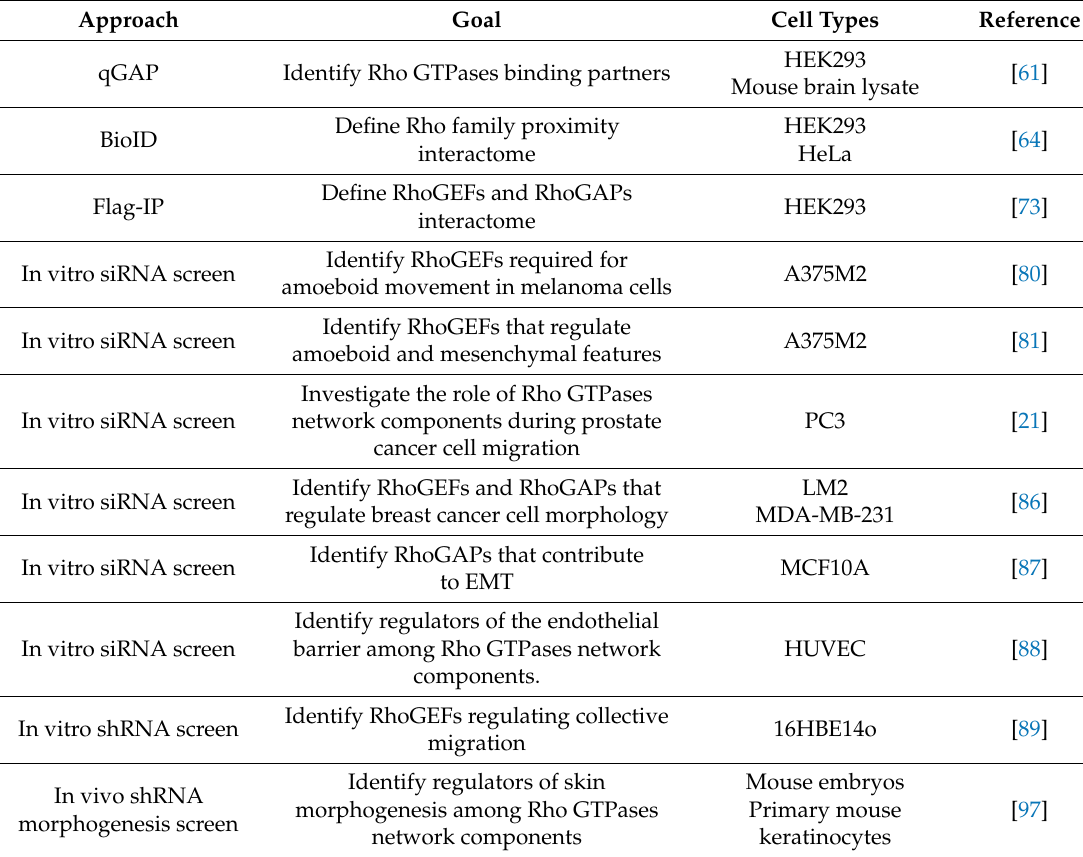
Table 1. Overview of high throughput